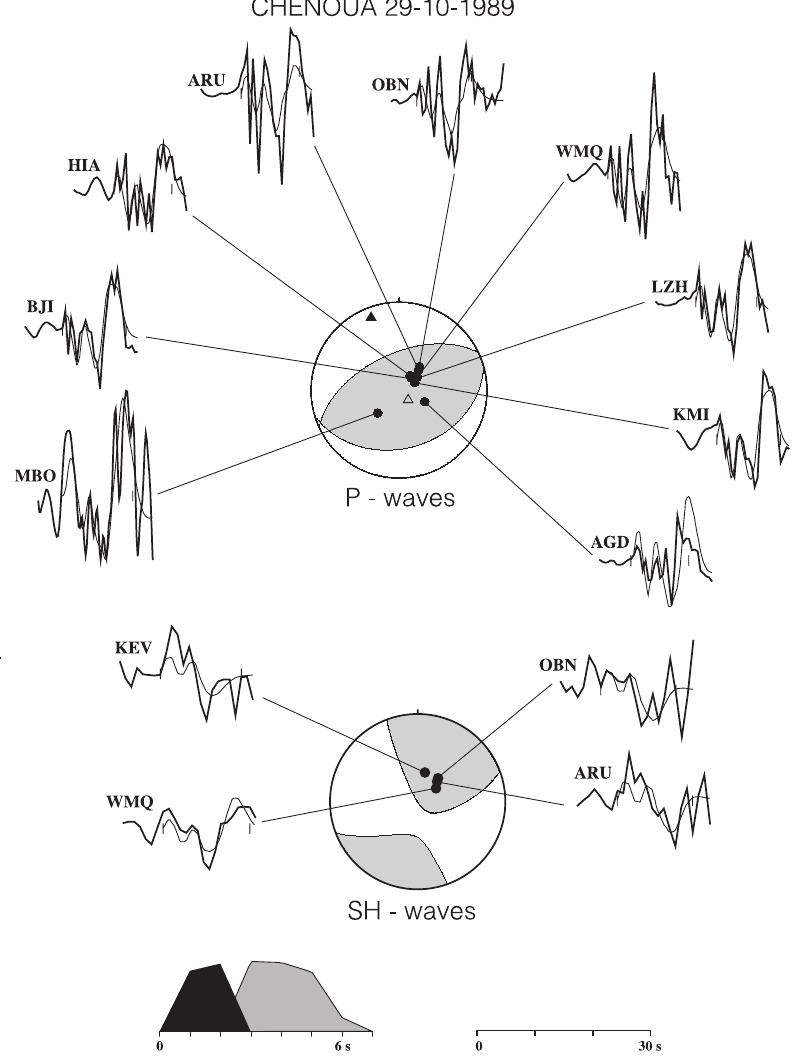
Fig. 3. Comparison between observed BRB and synthetic signals for the fi nal model consisting of two sub-events (step II). Conventions as in fi g.